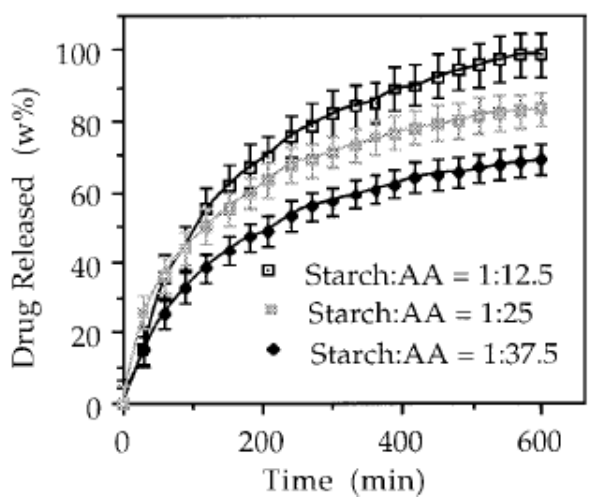
Figure 4. Rate of release of theophylline from graft copolymers obtained from grafting starch with acrylic acid in weight ratios of 1:12.5; 1:25, and 1:37.5: used permission from [146]. Copyright 2020 John Wiley and Sons.